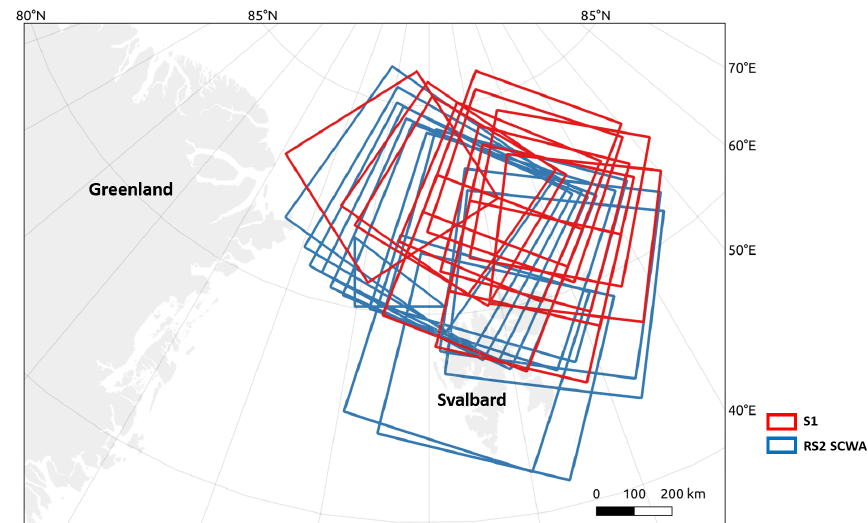
Figure 2. Extents and overlaps of S1 and RS2 SCWA scenes used in this